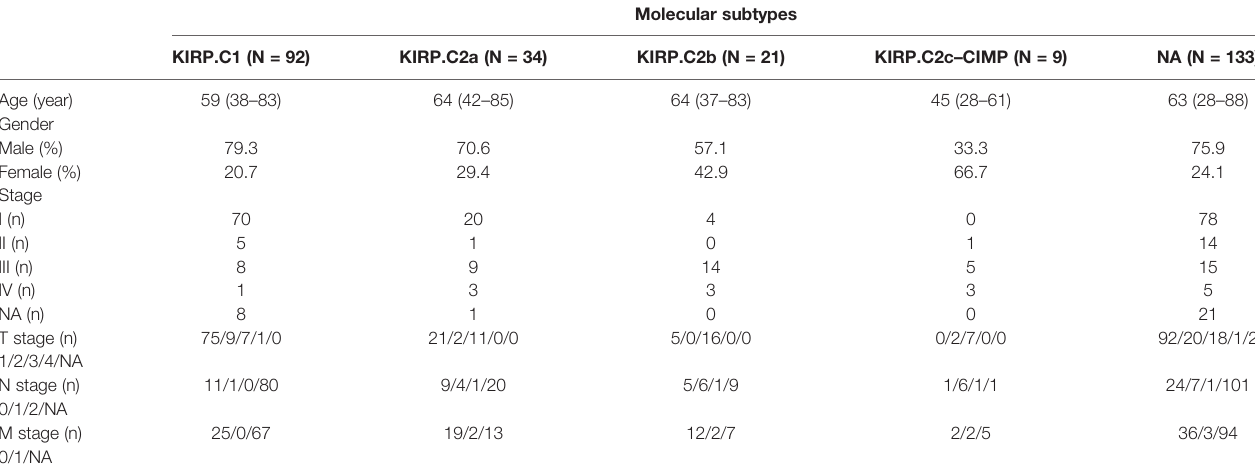
TABLE 2 | Summary of clinical characteristics of molecular subtypes in the KIRP-TCGA